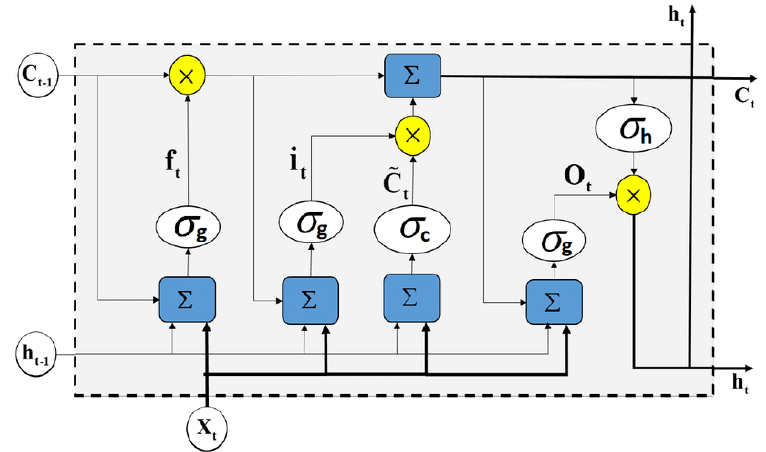
Figure 3. LSTM architecture cell.